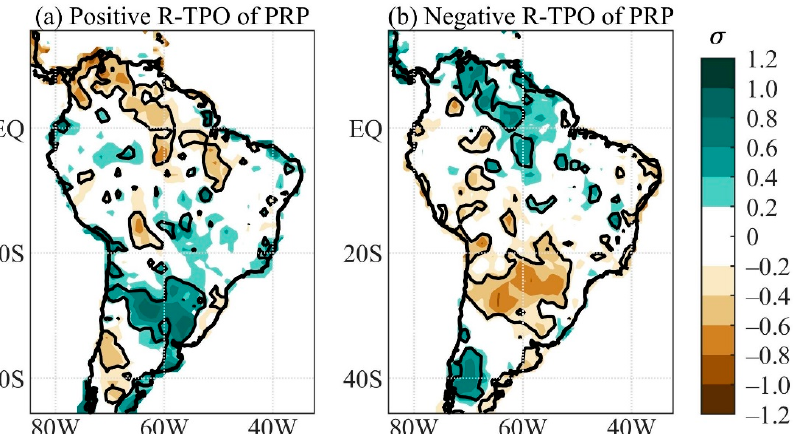
Figure 6. Composites of the residual precipitation anomalies during austral spring for the: ( a ) positive R-TPO; ( b ) negative R-TPO. In this Figure, residual means without the IOD effects. Continuous contours encompass significant values at a 95% confidence level using the Student’s t -test.